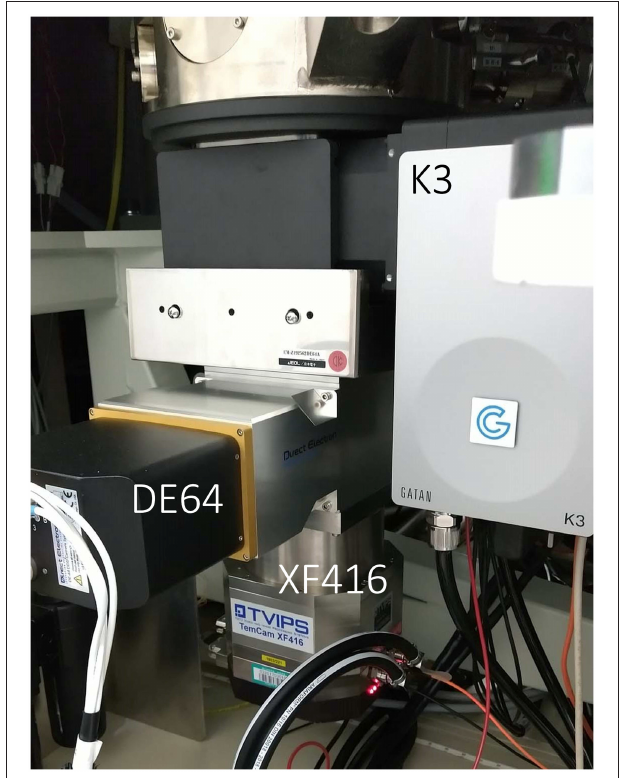
FIGURE 1 | Camera setup in a CRYO ARM 300 electron microscope at RIKEN SPring-8 Center. A GATAN K3 (upper), Direct Electron DE64 (middle), and TVIPS XF416 (lower) were installed below the column of the electron